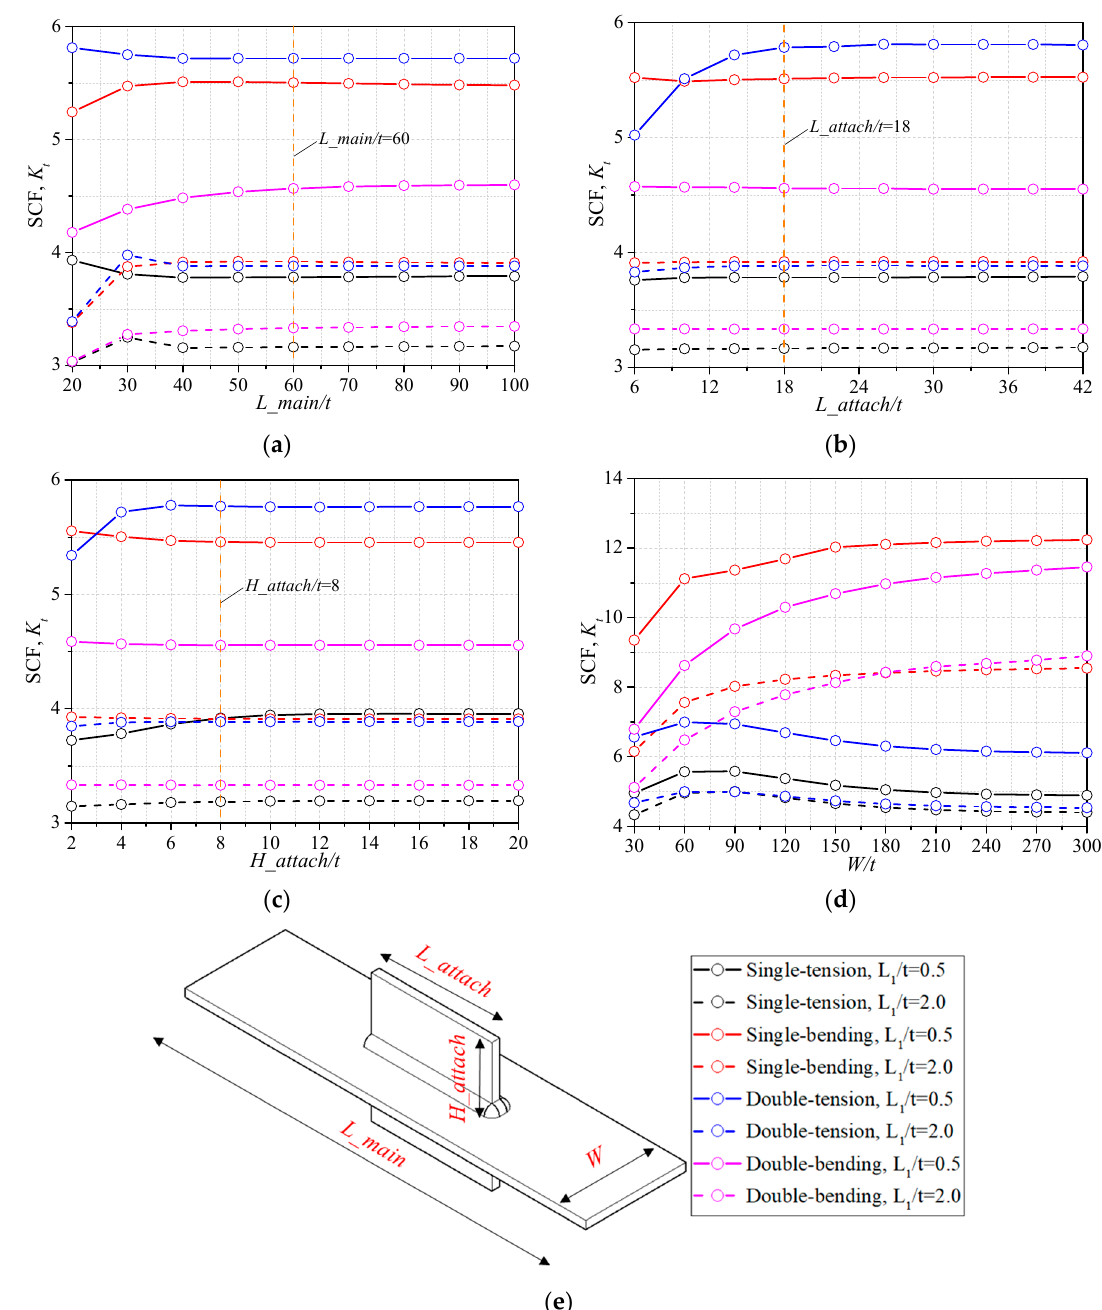
Figure 5. Influence of the base metal geometry: ( a ) L_main / t ; ( b ) L_attach / t ; ( c ) H_main / t ; ( d ) W / t ; ( e ) the geometry of base metal.